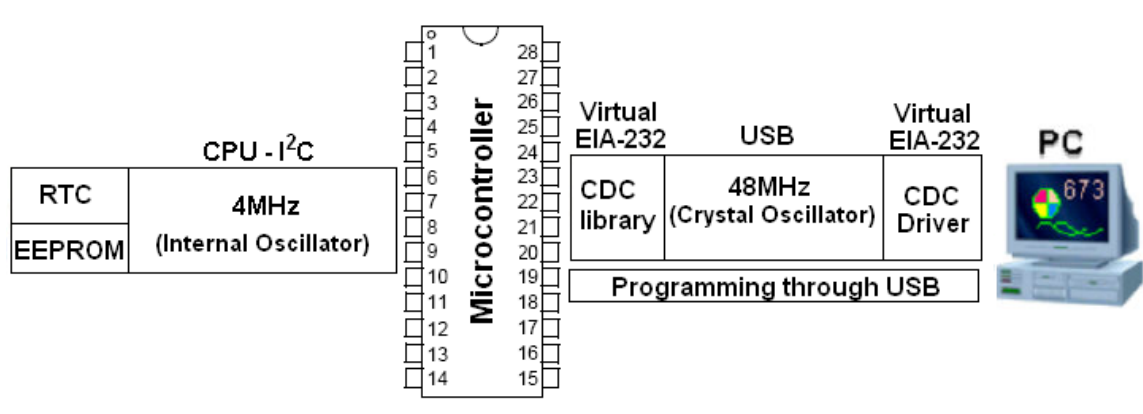
Figure 4. Developed dual clock